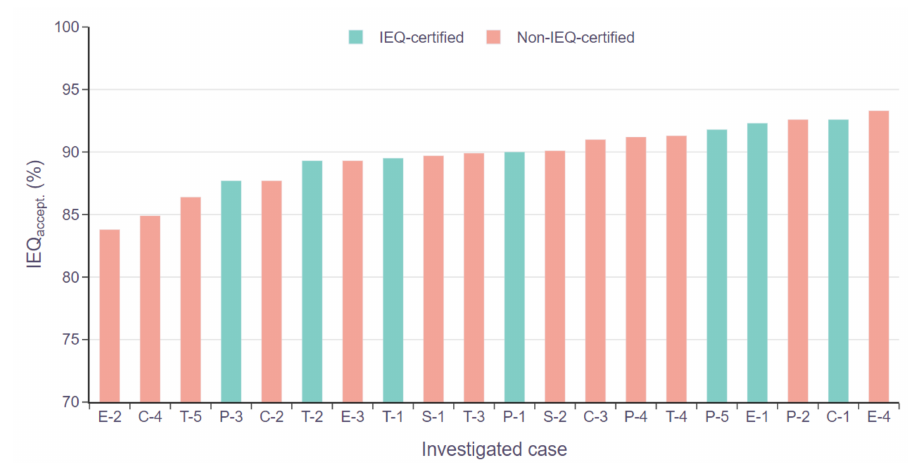
Figure 5. Annual average IEQ scores of the investigated cases.